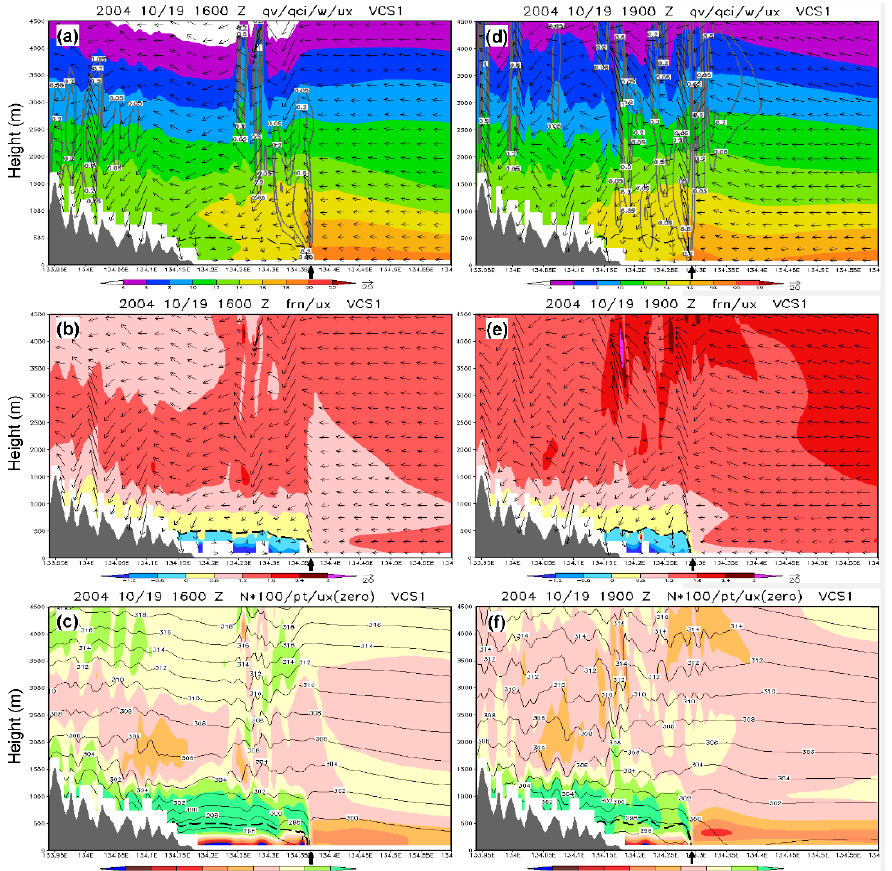
Figure 10. Model-simulated ( a ) water vapor mixing ratio ( q v , g kg − 1 , shading), cloud mixing ratio (cloud rain plus ice ( q c + q i ), g kg − 1 , gray contours), and wind vectors along the section plane (m s − 1 , aspect ratio of vertical/horizontal components is the same as panel height/width); ( b ) Fr (shading, expressed as negative for offshore flow) and wind vectors along section plane as in ( b ); and ( c ) buoyancy oscillation frequency ( N , 10 − 2 s − 1 , shading) and θ (K, black contours) along VCS1 at 1600 UTC 19 October 2004. ( d – f ) Same as ( a – c ), except at 1900 UTC 19 October 2004. The thick, dashed lines denote the boundary of onshore/offshore flow, and the rainband location at the surface is also marked along the x -axis (short vertical arrow).